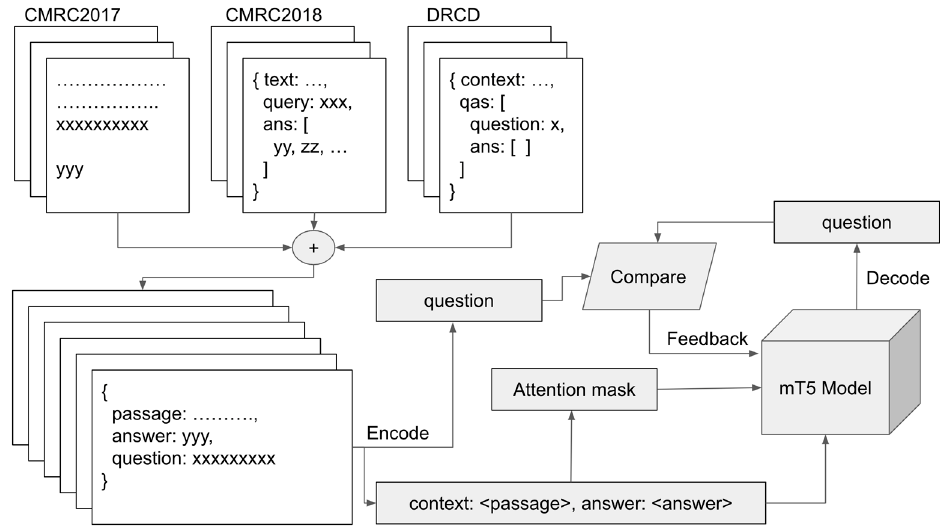
Figure 1. The flow of the machine learner: dataset preparation, encoder, decoder, and transformer.